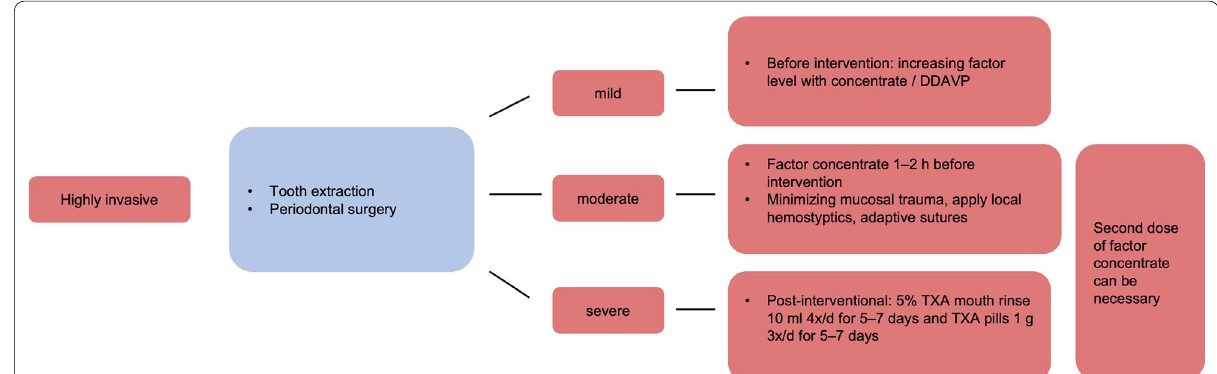
Fig. 4 Exemplary treatment scheme for highly invasive dental treatments. High risk (red) (acc. to [2]). TXA: tranexamic acid; DDAVP: